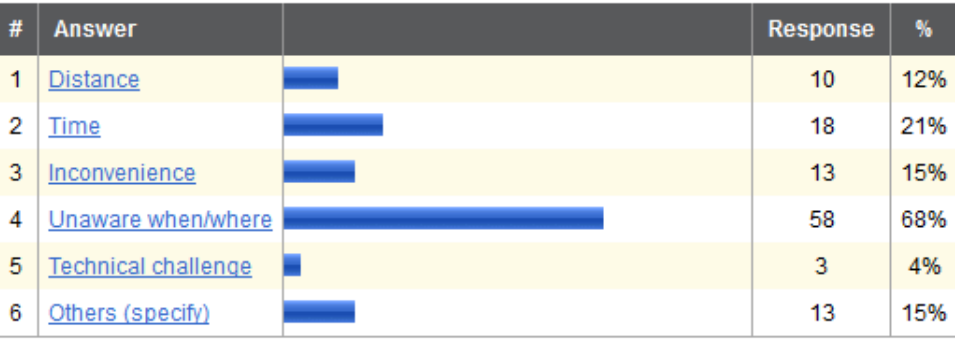
Figure 4. Frequency table for Question 8: If you do not want to participate in an EIA, what is the primary reason (check all that apply)?